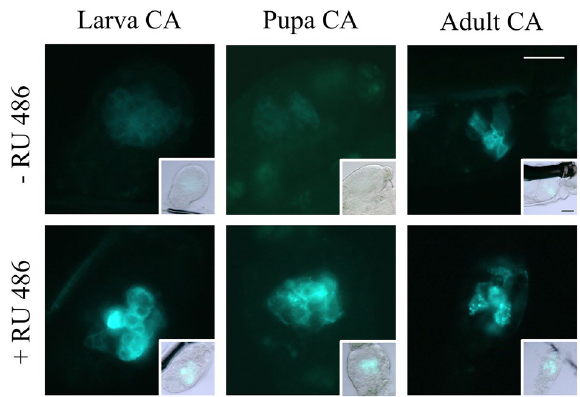
Figure 7. Induction of GFP expression. Fluorescent images show GFP expression in CA from 4th instar larva, pupa, and female adults without (−) or with (+) RU486 induction. Inset shows bright field images overlaid with fluorescence. Scale bar, 25